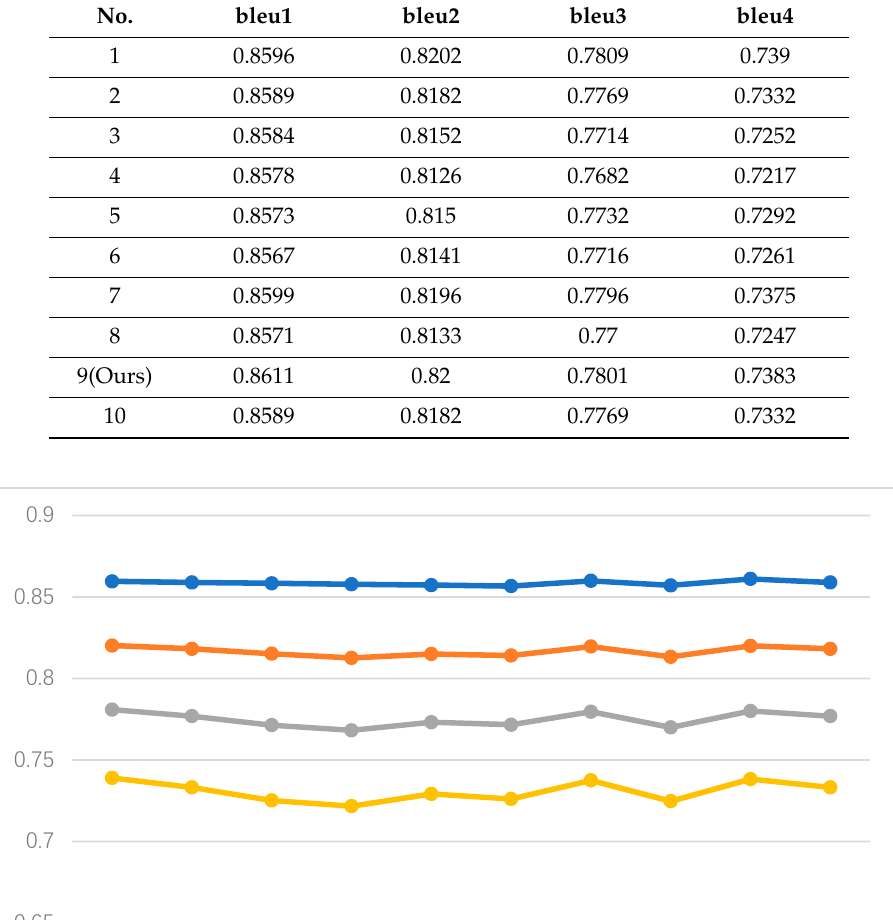
Table 3. Bleu values of the 10 Monte Carlo runs.